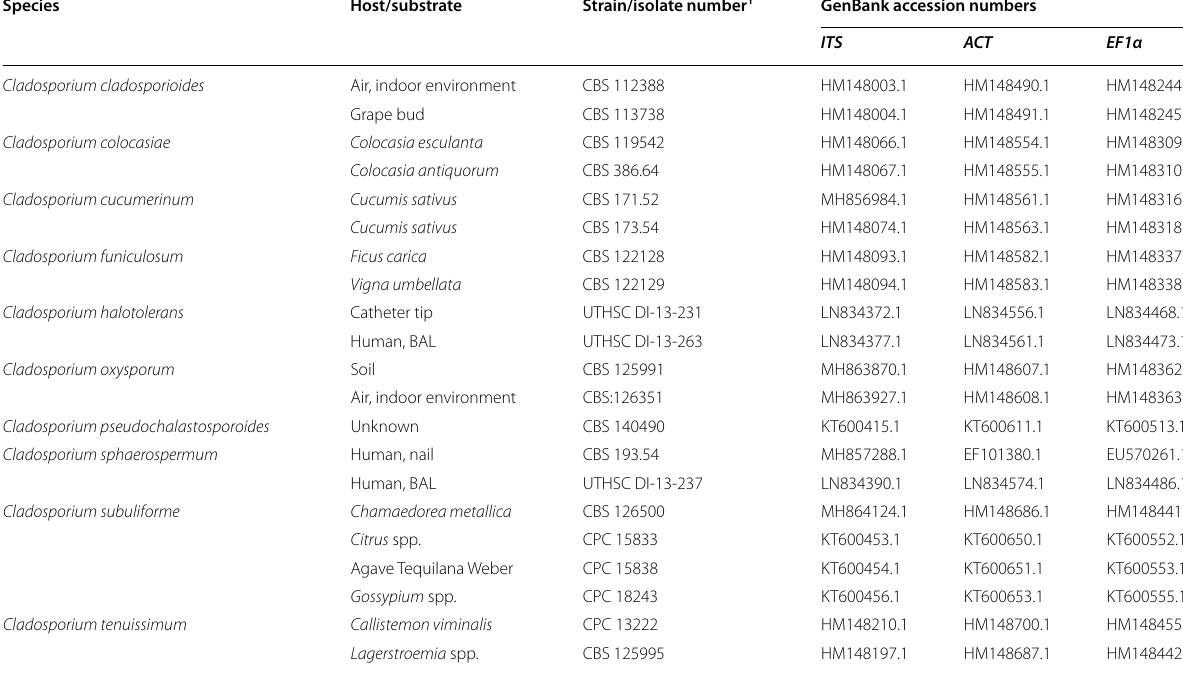
Fig. 1 Cladosporium subuliforme isolate wz‑1 on PDA medium and its infection on the adult of D. citri. A The fungal colonies on PDA (Petri dishes with 90 15 mm); B The back of fungal colonies on PDA; C Trifurcate conidiophore with ramoconidia and conidia; D Subulate conidiophore, scale bars × E D. citri adult 7 days post infection (dpi) by C. subuliforme with 1 Table 1 GenBank accession numbers of DNA sequences of Cladosporium species, used in the phylogenetic analysis